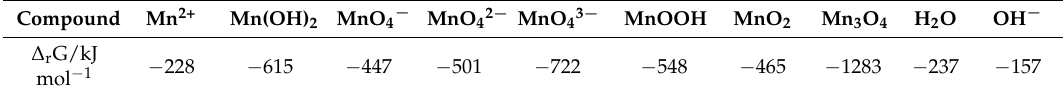
Table 1. Overview of standard free Gibbs enthalpies of reaction compounds involved in MnO 2 formation [32–34]. Formulas and oxidation states of all involved compounds are listed in Table A1. Compound Mn